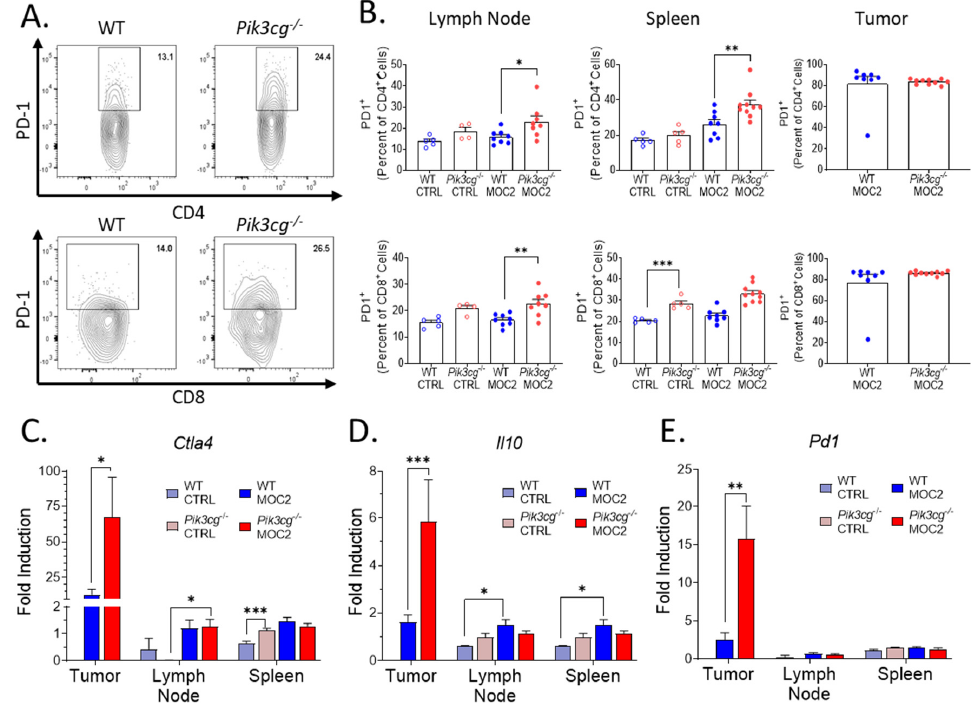
Figure 4. PD-1 expression by T-cells is upregulated in Pik3cg − / − mice ( A ) Flow cytometry gating strategy for CD4 + PD-1 + T-cells and CD8 + PD-1 + T-cells. ( B ) Population frequencies of CD4 + PD-1 + T-cells and CD8 + PD-1 + T-cells among parent T-cell populations in the lymph node, spleen and tumor. ( C – E ) Expression of ( C ) Ctla4, ( D ) Il10, ( E ) Pd1 , and within the sentinel lymph nodes, spleens, and tumors of experimental mice determined by RT-qPCR. * p -value < 0.05; ** p -value < 0.01; *** p -value < 0.005 between groups, as determined by Student’s t- test.